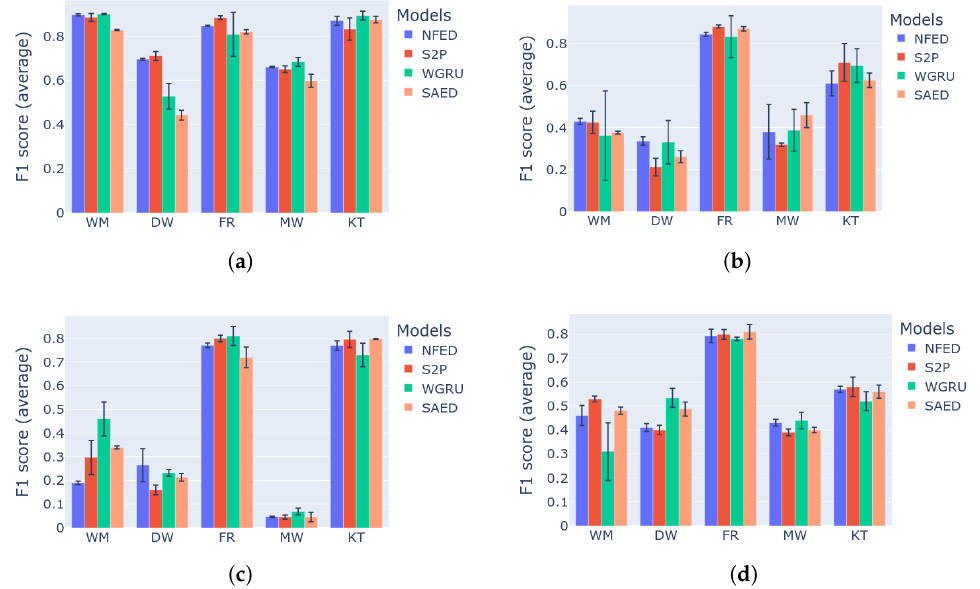
Figure 7. Benchmark results for the models NFED, S2P, WGRU and SAED. ( a ) Category 1: Single building NILM: ( b ) category 2: single building learning and generalization on the same dataset; ( c ) category 3: multi building learning and generalization on the same dataset; ( d ) category 4: generalization on a different dataset.